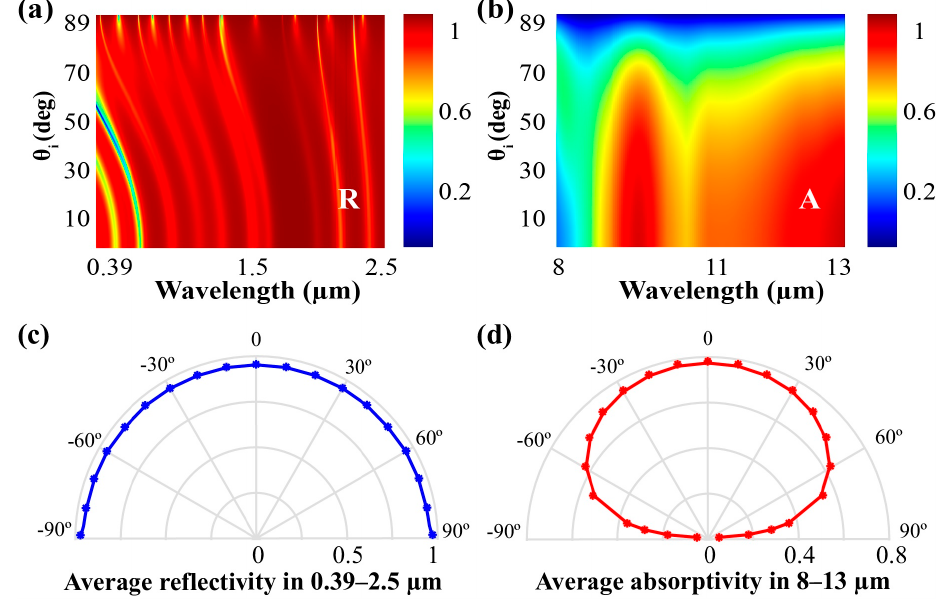
Figure 3. Spectra properties of the radiative cooling material with varying incident angles ( θ i ). ( a ) Reflectivity of the coating of 0.39–2.5 μ m with varying incident angles; ( b ) absorptivity of the coating of 8–13 μ m with varying incident angles; ( c ) average reflectivity in visible and near-infrared wavelength ranges (0.39–3.5 μ m) with the incident angle changes from -90° to 90°; ( d ) average absorptivity over mid-infrared wavelength ranges (8–13 μ m) with the incident angle changes from − 90° to 90°.